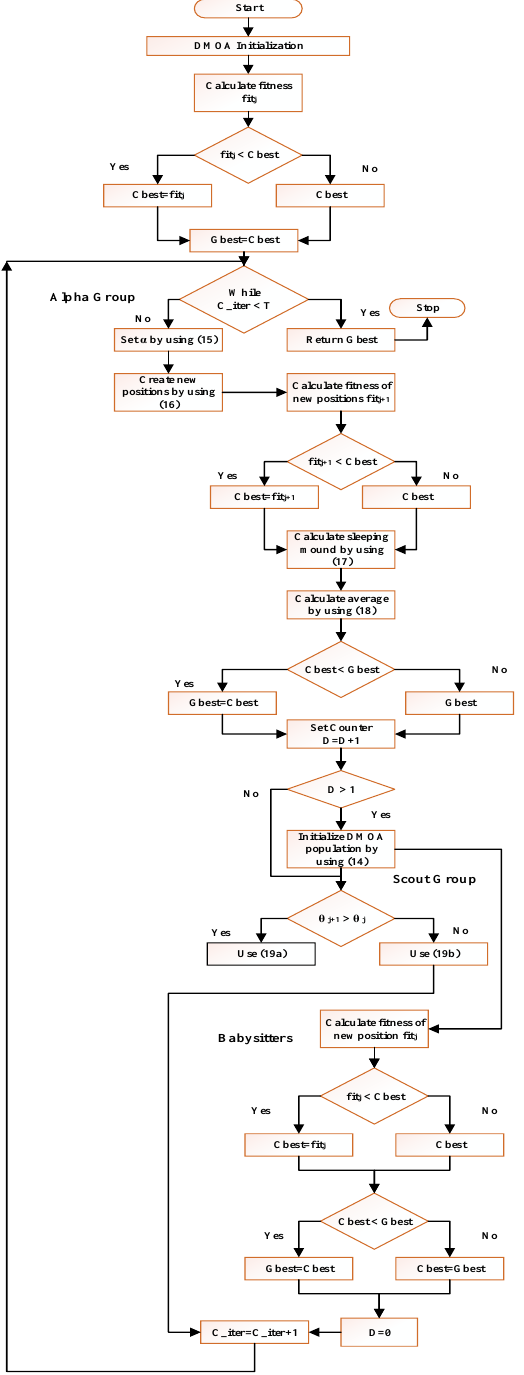
Figure 2. DMOA Flowchart.